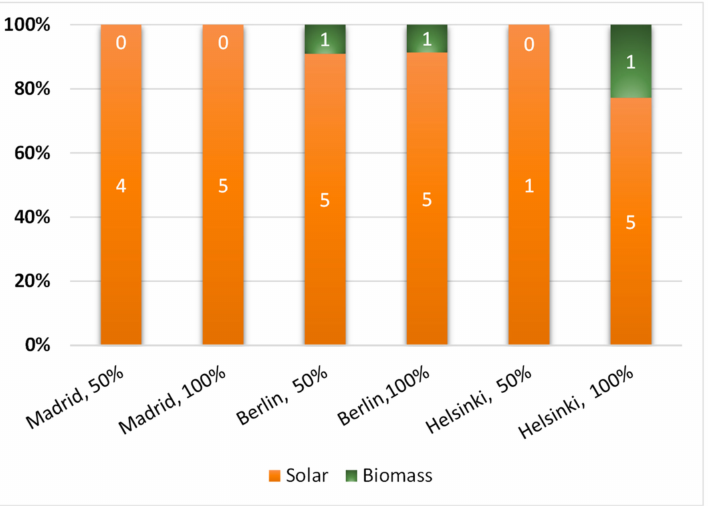
Figure 10. Relative share of heating sources for DHW. The numbers in white indicate the kWh/(m 2